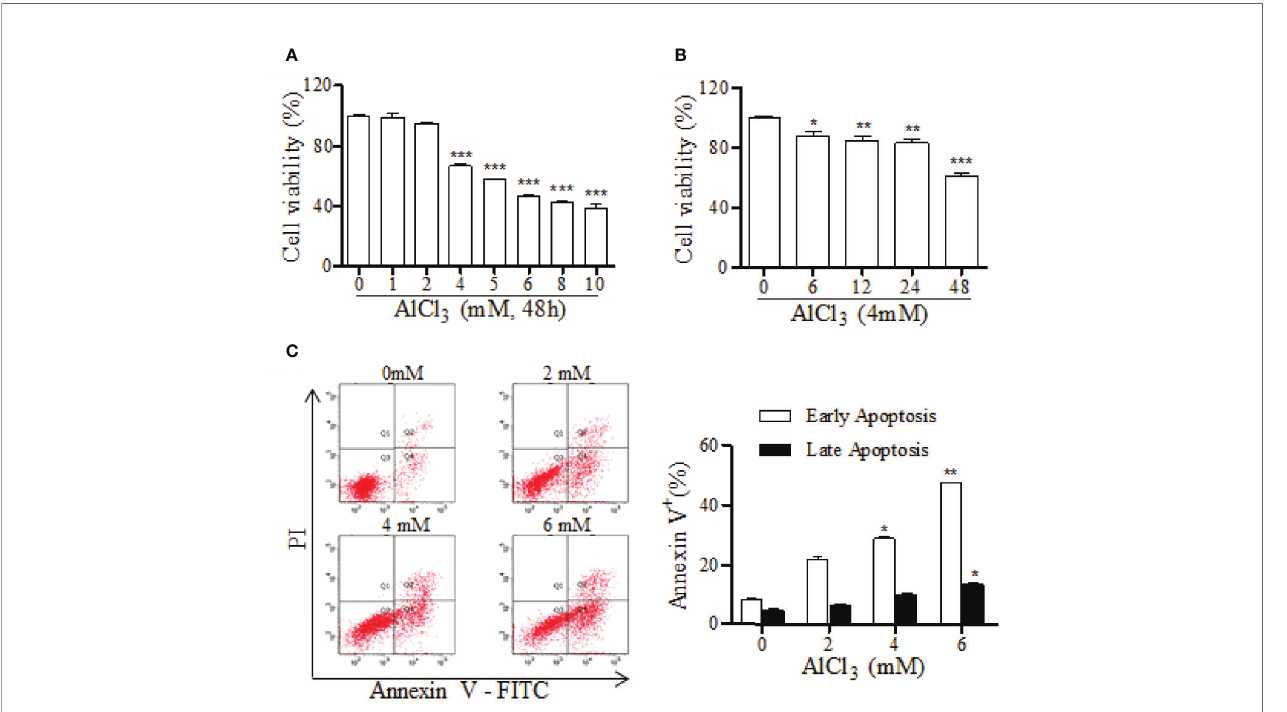
FIGURE 2 | AlCl 3 ·decreases cell viability and increases apoptosis in PC12 cells. (A) The neurotoxic effect of AlCl 3 with different concentrations (1, 2, 4, 5, 6, 8, and 10 mM) was determined by an MTT assay. (B) The effects of AlCl 3 incubation at 4 mM for different hours (6, 12, 24, and 48 h) on cell viability were assessed by an MTT assay. (C) After 48 h incubation, AlCl 3 -induced apoptosis was determined with annexin-V/PI staining, followed by FACS analysis. The bar graph on the right shows the percentages of cells in early and late apoptosis. Values are means ± standard derivation from three independent experiments. * p < 0.05, ** p < 0.01, *** p < 0.001 vs. 0